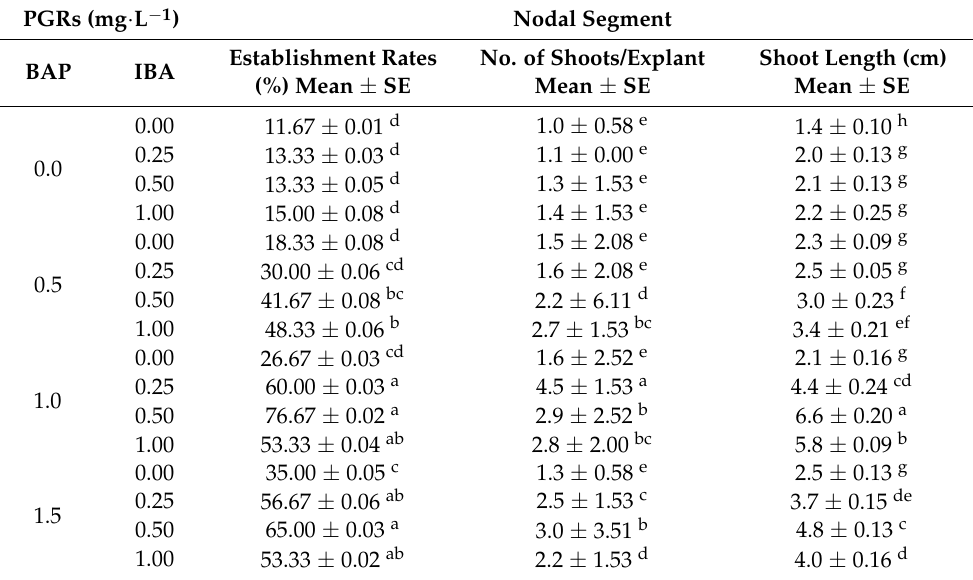
Table 2. Effect of BAP and IBA combinations on in vitro propagation of A. crenata var. bicolor